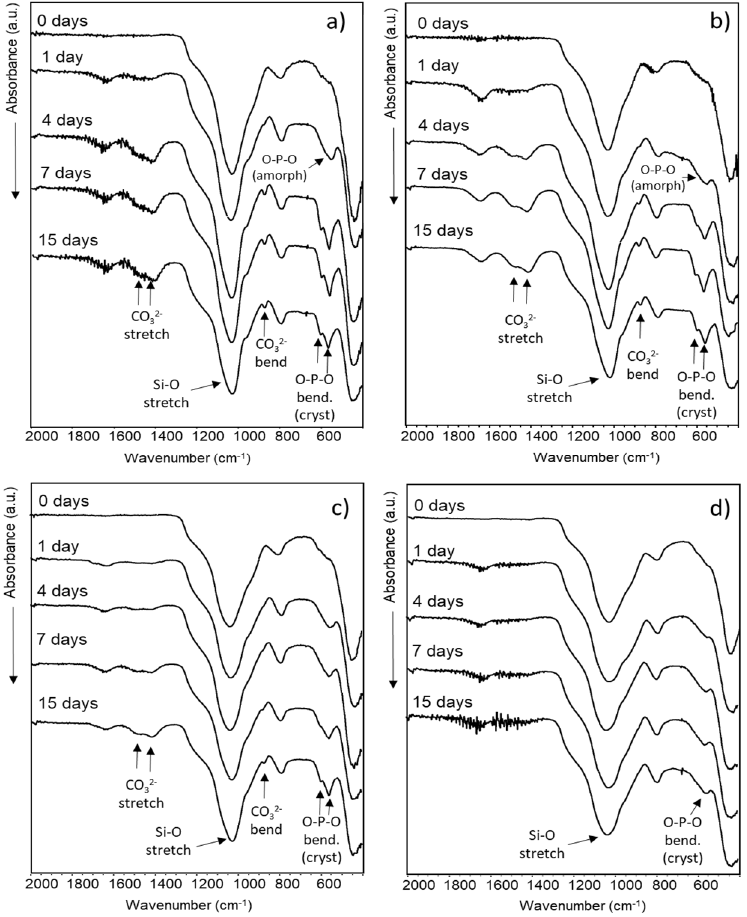
Figure 5. FTIR spectra of ( a ) MBG, ( b ) MBG-Zn1, ( c ) MBG-Zn3, and ( d ) MBG-Zn5 collected as a function of soaking time in SBF.